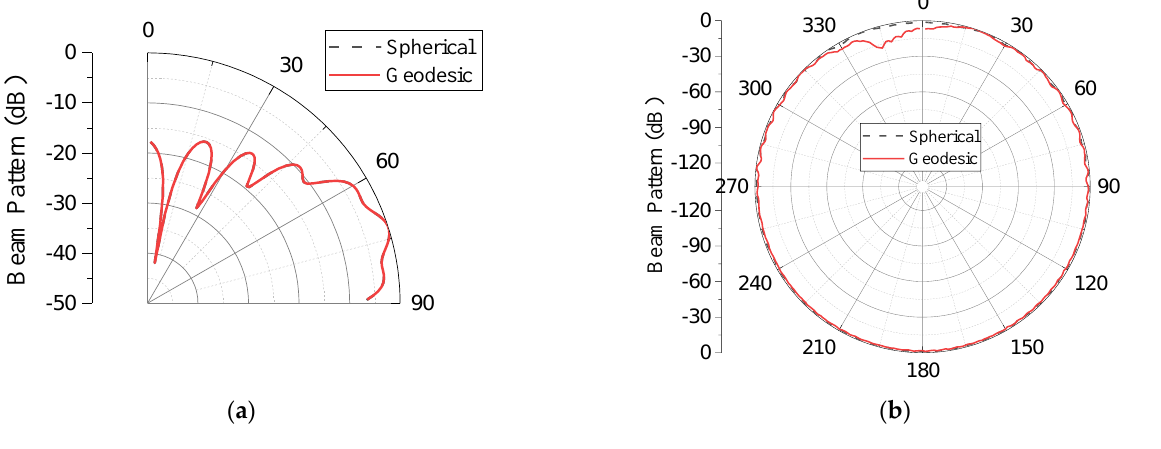
Figure 14. Comparison between the beam patterns of the SA and GFA: ( a ) elevation plane; ( b ) azimuth plane.